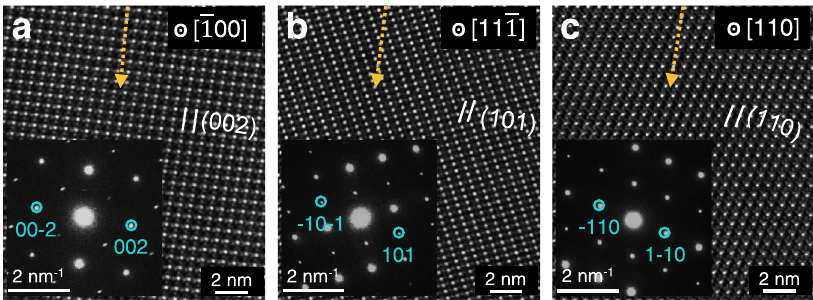
Fig. 4 | Crystal orientation of plagioclase grains implanted by solar wind par- ticles. a – c High-resolution (HR) TEM images and corresponding selected area electron diffraction (SAED) patterns depicting residual crystal planes along the [ − 100], [11-1], and [110] zone-axis for the plagioclase samples a CE-PL1, b CE-PL2,